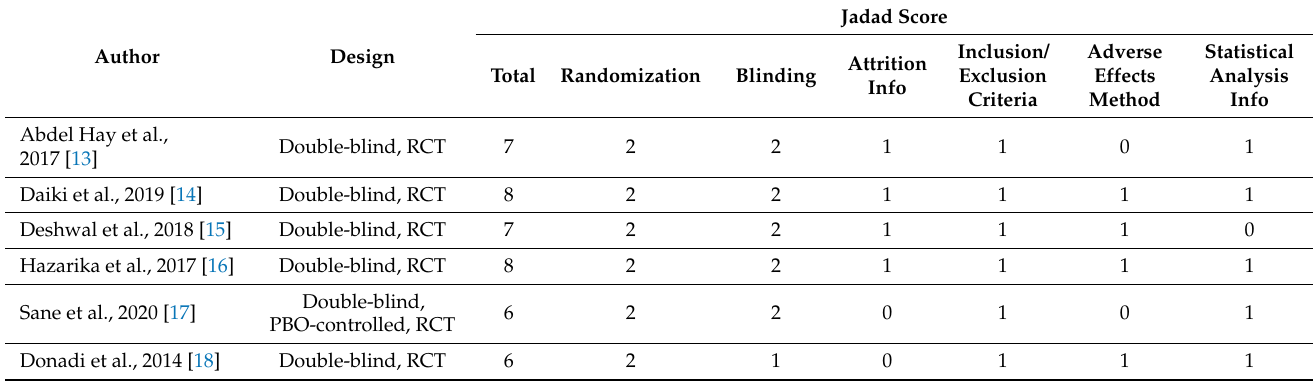
Table 1. Critical appraisal of randomized controlled trials assessing local wound infiltration for pain control after lumbar spine surgery using the modified Jadad score.